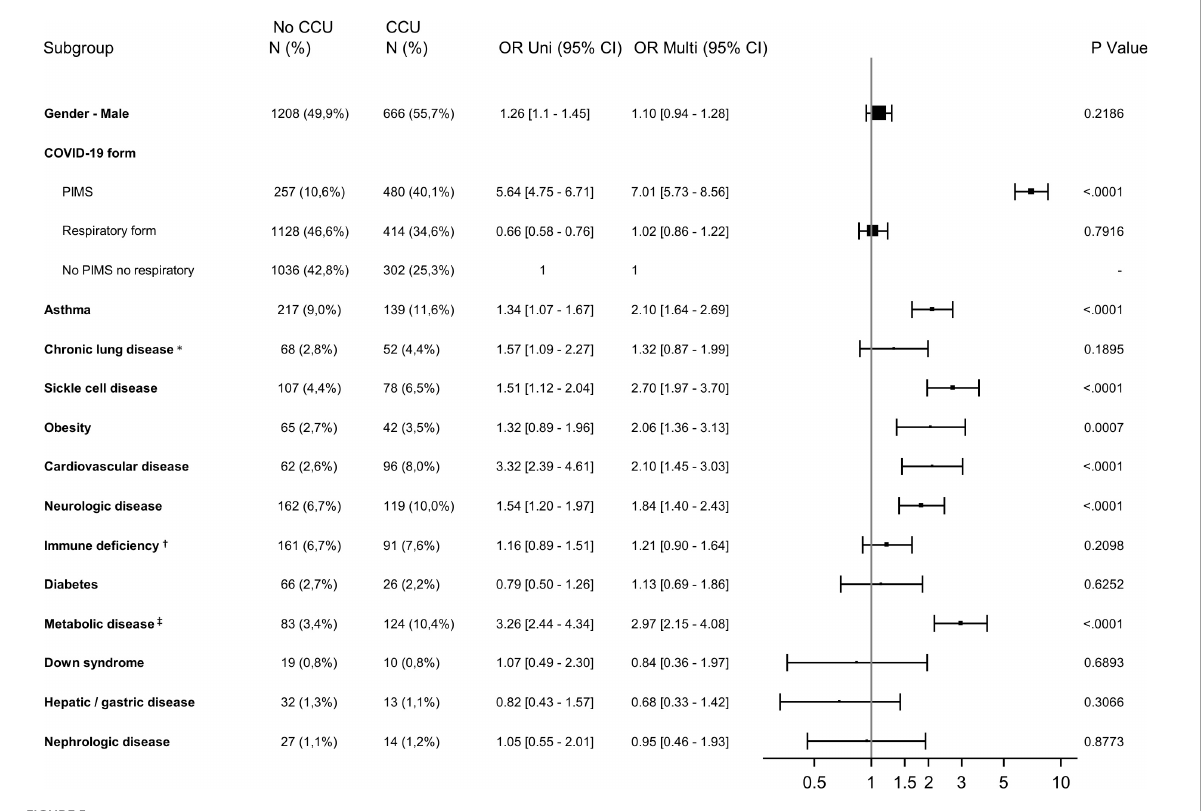
FIGURE5 Forest plot showing the odds ratio using univariable (Uni) and multivariable (Multi) logistic regression analysis for CCU admission for children older than 2 years old. CCU, critical care unit; PIMS, pediatric multisystem inflammatory syndrome; OR, odds ratio; 95% CI, 95% confidence interval. *Excluding asthma; † including cancers; ‡ excluding